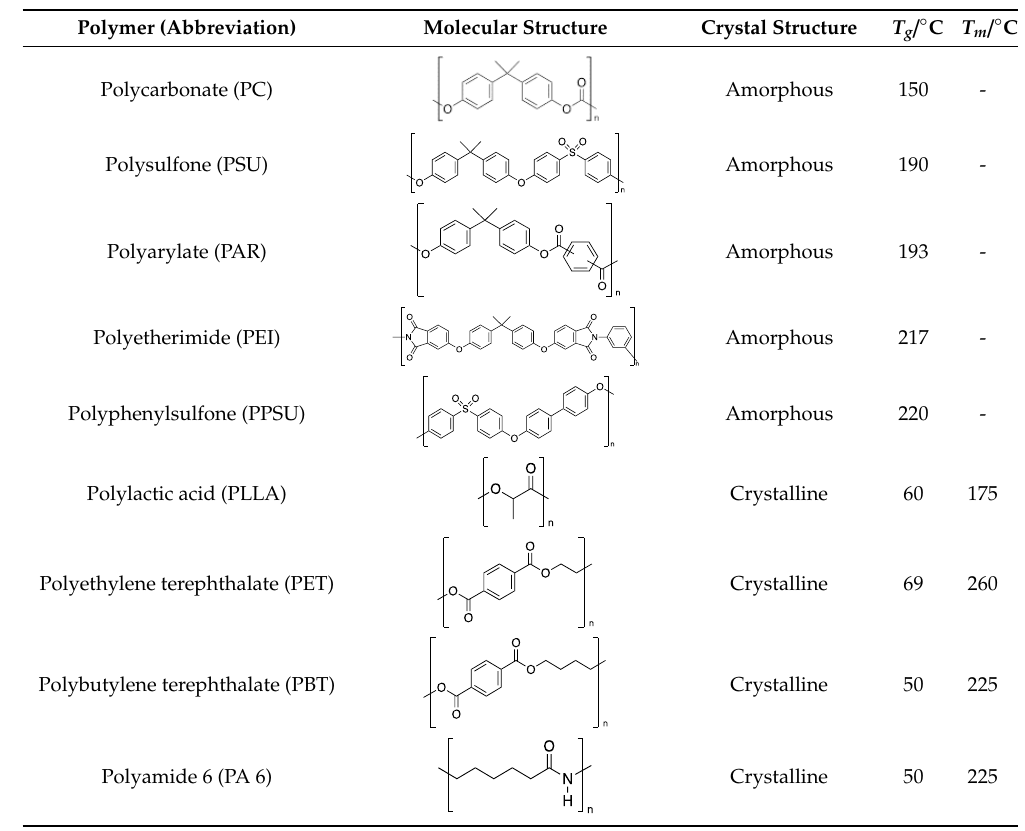
Table 1. Molecular structures, crystal structures, glass-transition points ( T g ), and melting points ( T m ) of engineering plastics.